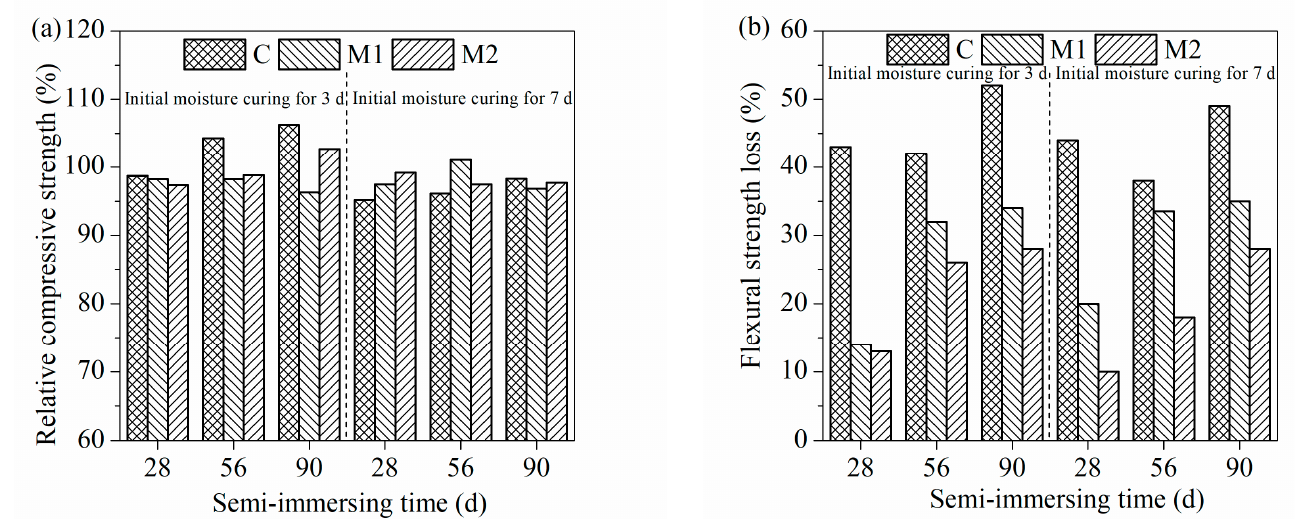
Figure 8. Results of sulphate attack: ( a ) relative compressive strength; ( b ) flexural strength loss.